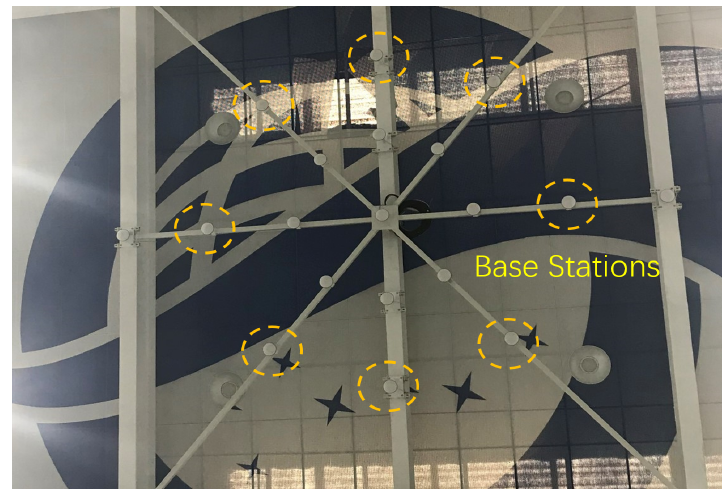
Figure 12. The base stations. The base station is deployed on the roof, and the coordinates are shown in Table 2. Table 2. Antenna Array Coordinates.